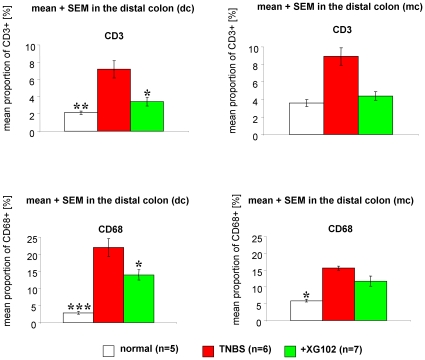
Infiltration and presence of CD3- and CD68-positive cells.The proportion (%) of CD3- or CD68-positive cells from all cells within a defined vision field in the distal and medial colon from normal mice (normal, n = 5), following rectal trinitrobenzene sulfonic acid (TNBS) administration only (TNBS, n = 6) and treatment with XG-102 (100 µg/kg sc.) (n = 7). *, ** = p<0.05 and p<0.01 compared with TNBS group.